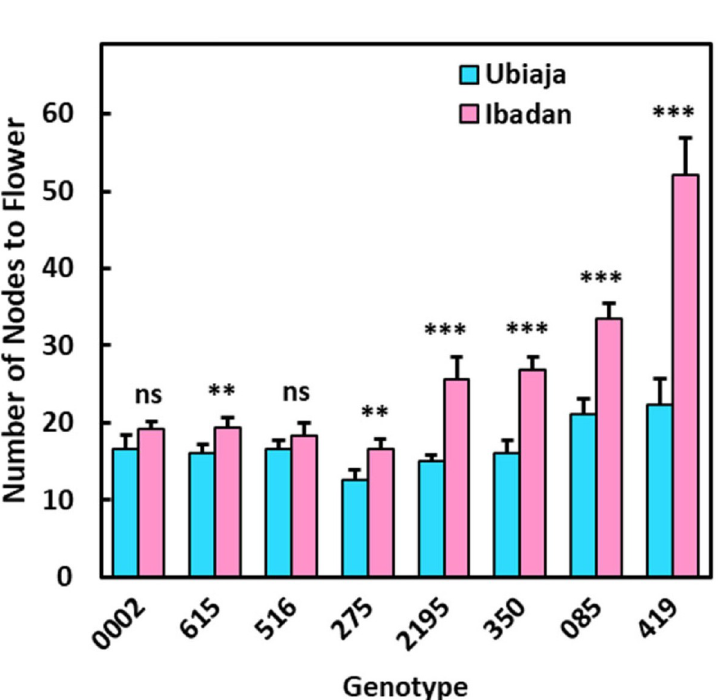
Fig 4. Number of nodes to flowering for eight genotypes grown in field locations of Ubiaja (blue) and Ibadan (red). Pairwise comparisons between locations are shown for each genotype at 0.05, 0.01 and 0.001 significance levels ( � , �� , ��� ), respectively, and those not significant (ns). Mean number of nodes are reported while data was square-root transformed for statistical analysis.